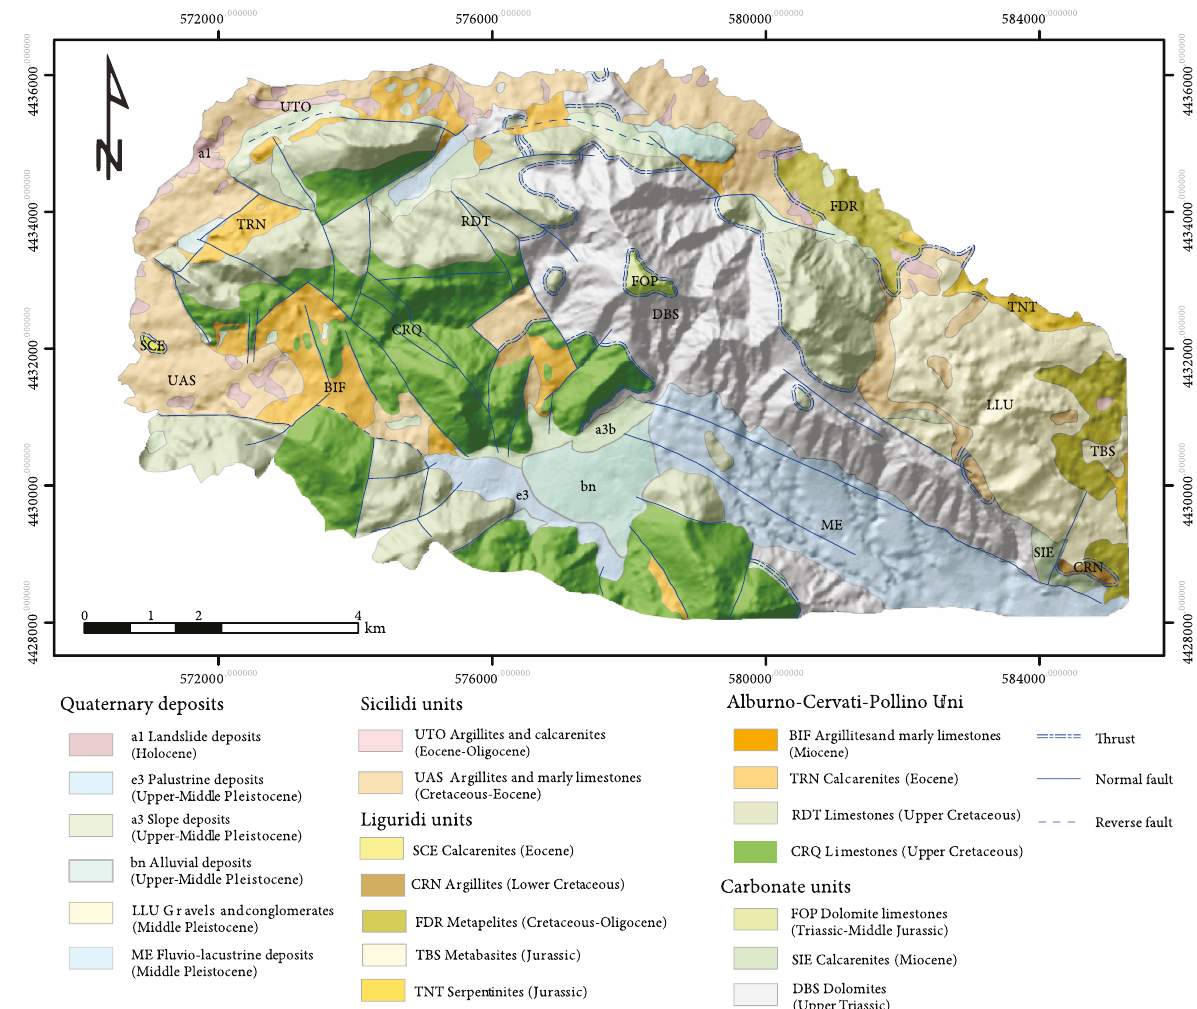
Figure 2: Geological map of the Lauria Mountains northern sector (adapted from ISPRA, 2016